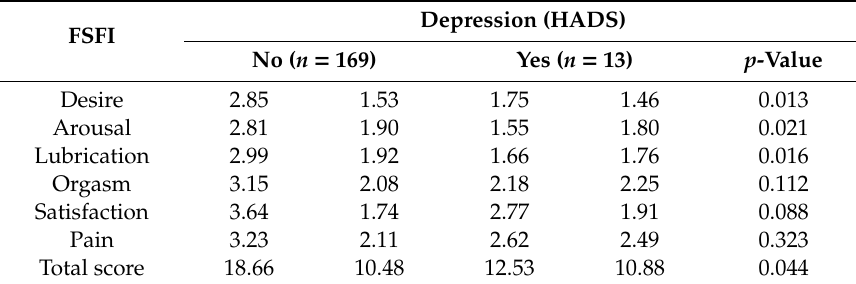
Table 3. Female sexual function according to the depression ( n =